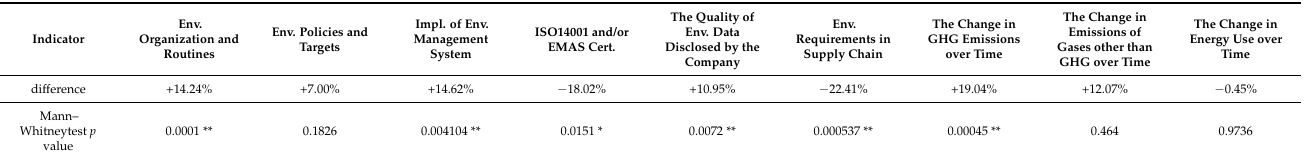
Table 5. Differences in mean values of grades obtained in environmental area by groups of mining, energy, and energy utilities compared to other companies under research.